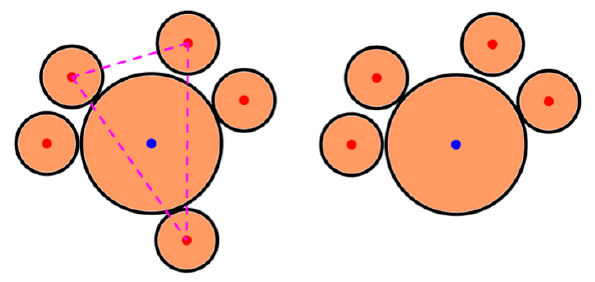
Figure 8. Graphical representation of the concept of caged and uncaged particles: the large particle illustrated on the left is caged by the three small particles forming the triangle with dotted magenta sides; the large particle on the right is not caged by any combination of small particles.